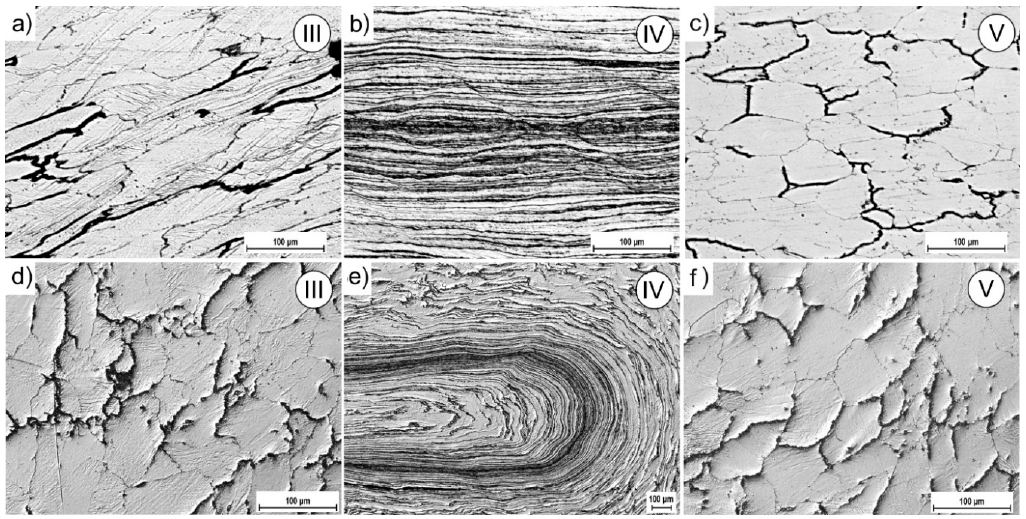
Figure 9. Microstructure of Fe-22Al-5Cr alloy from Figure 8: ( a – c ) One pass and ( d – f ) two passes of CCE.